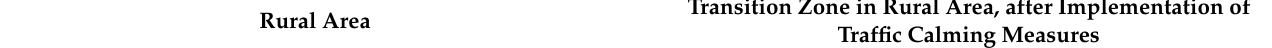
Table 1. Compilation of the reductions in road crash rates on road sections through villages due to the use of traffic calming measures and various speed management strategies.